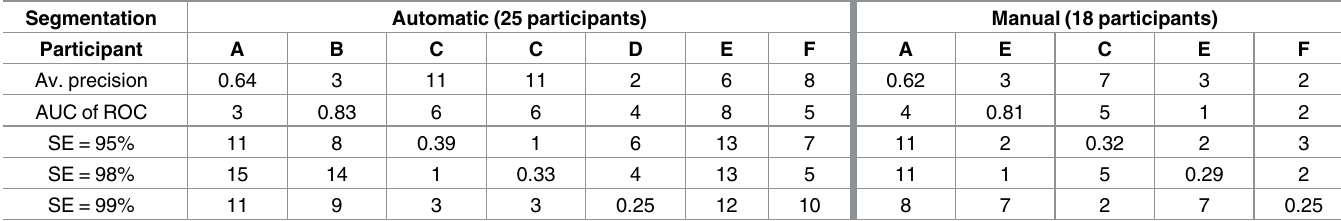
Table 1. Rankings for those participants that were highest ranked by one